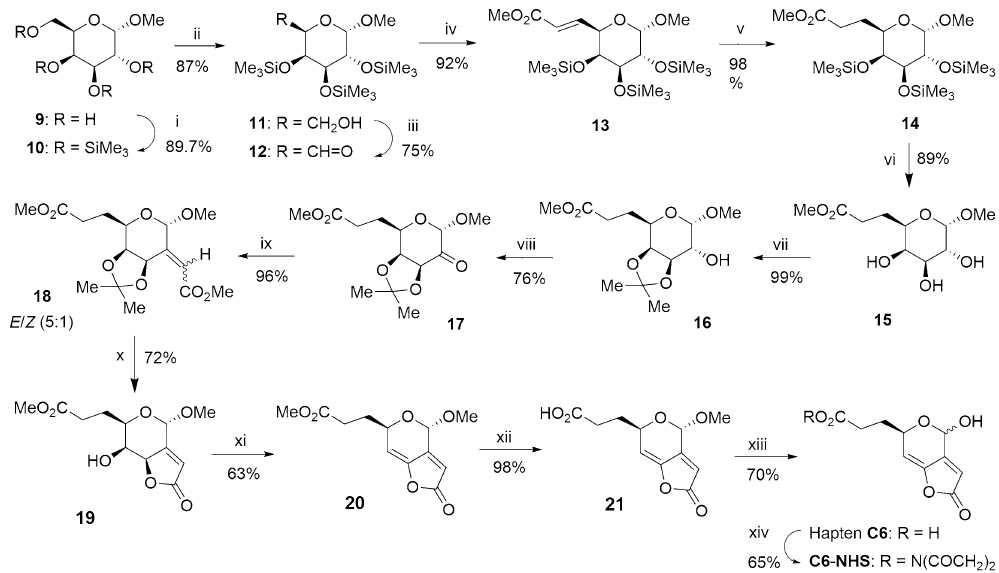
Figure 3. Synthetic route for the preparation of hapten C6 . Reagents and conditions: (i) HMDS, TMSOTf,